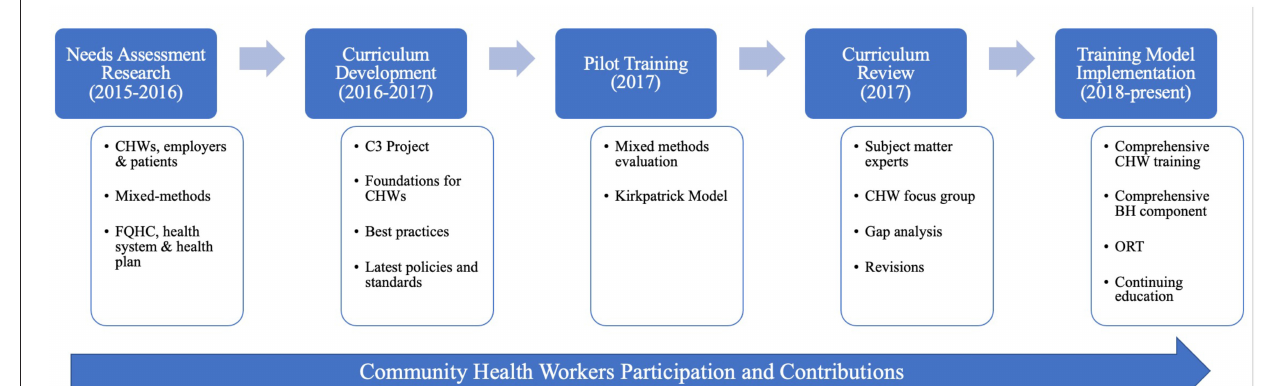
FIGURE 1 | Comprehensive training model